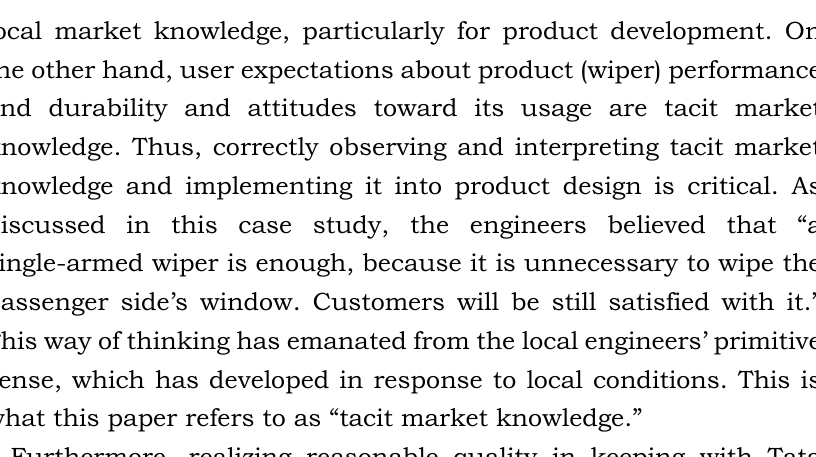
Figure 2. Wiping width comparison